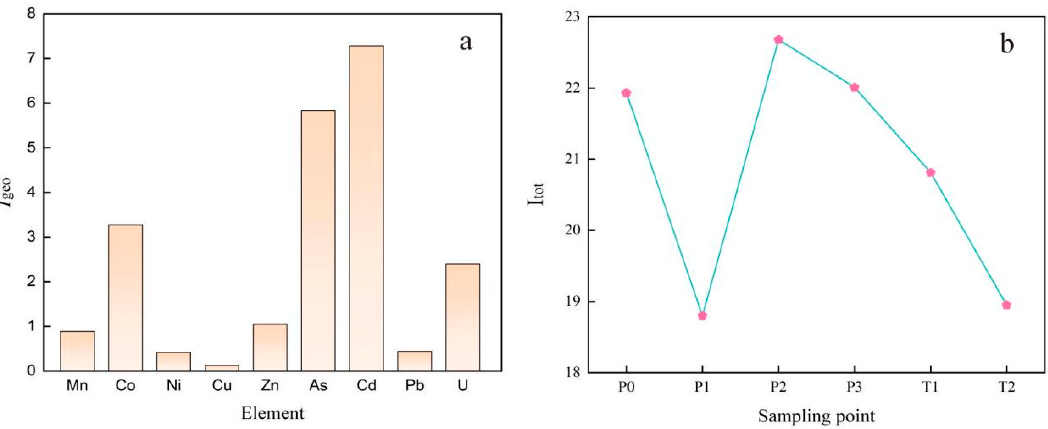
Figure 2. Mean plot of soil uranium and heavy metal accumulation index ( a ) and sum plot ( b ) of a uranium mining area in northern Guangdong. uranium mining area in northern